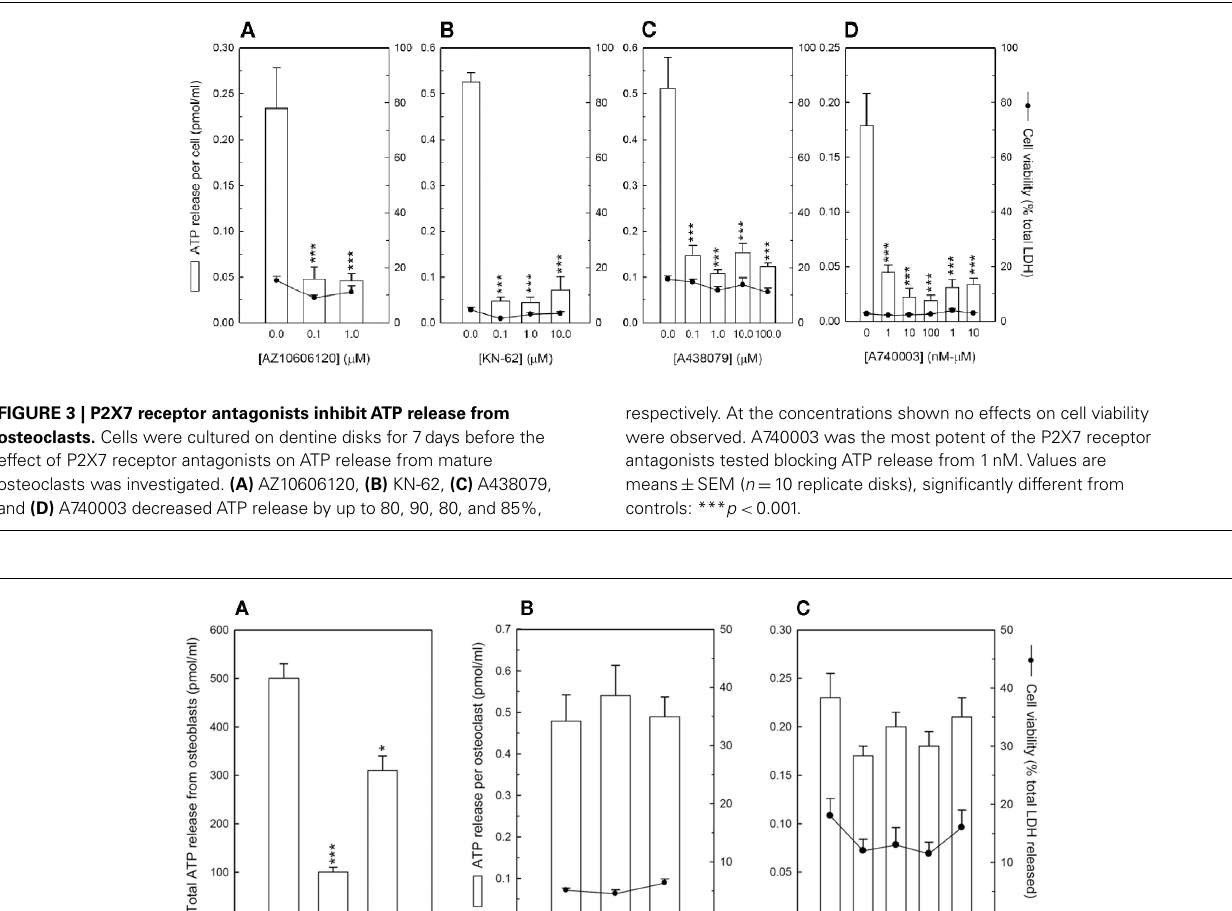
ATP release from mature osteoclasts was investigated. (B) NEM and, (C) brefeldin A had no effect on ATP release from osteoclasts. At the concentrations shown no effects on cell viability were observed.Values are means ± SEM ( n = 10 replicate